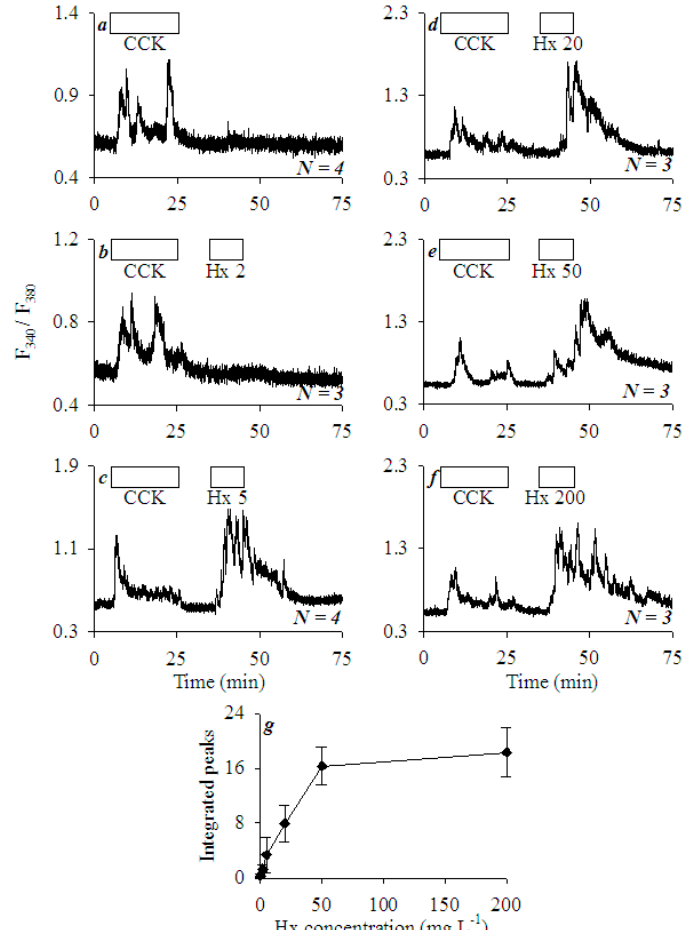
Figure 2. Mixed histones (Hx) induced calcium oscillations in AR4-2J cells. Fura-2-loaded AR4-2J cells were perifused; CCK (20 pM) and mixed histones (0, 2, 5, 20, 50, and 200 mgL − 1 ) were added as indicated by the horizontal bars. CCK (20 pM) was added, followed by mixed histones (Hx) at 0 ( a ), 2 ( b ), 5 ( c ), 20 ( d ), 50 ( e ), and 200 ( f ) (mgL − 1 ). The calcium traces shown are each representative of N identical experiments as indicated. Integrated Hx response (area under calcium peaks above the basal level, 35–75 min) from ( a – f ) was plotted against histone concentrations ( g ). Data were expressed as mean ± SEM.